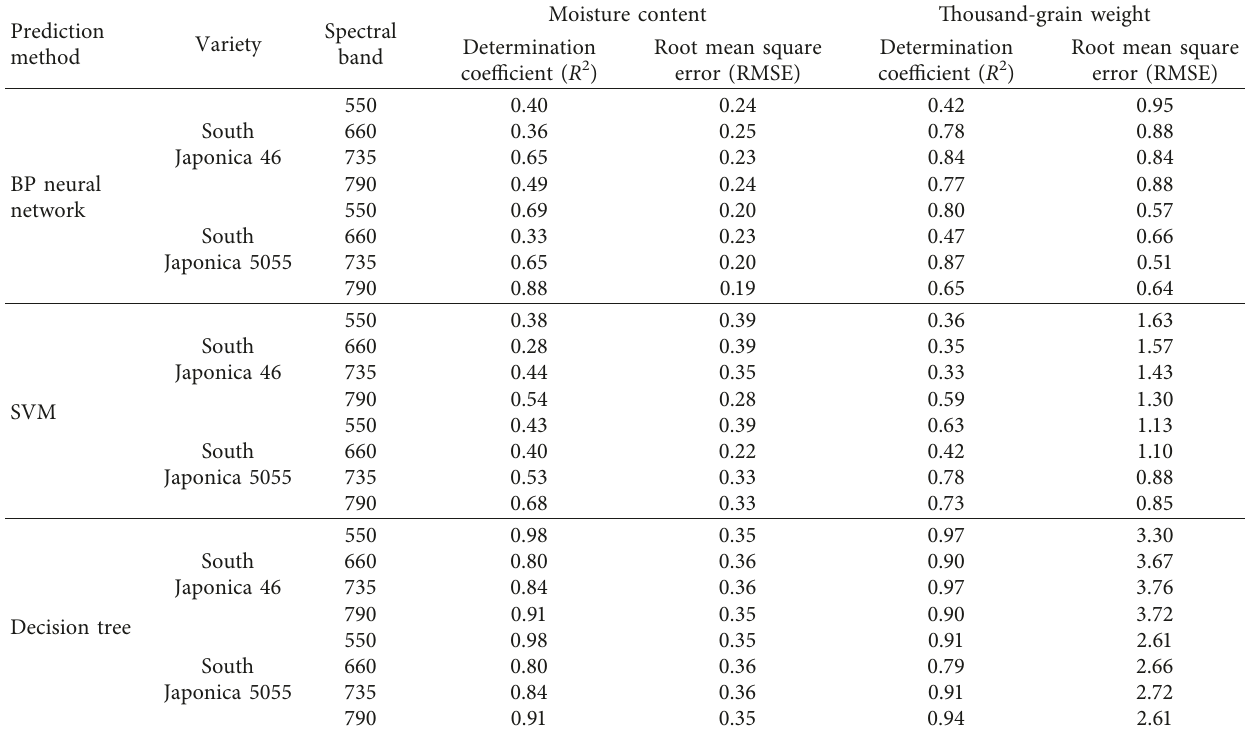
Table 4: Regression test results of single-band spectral reflectance and physiological indexes of rice. Prediction